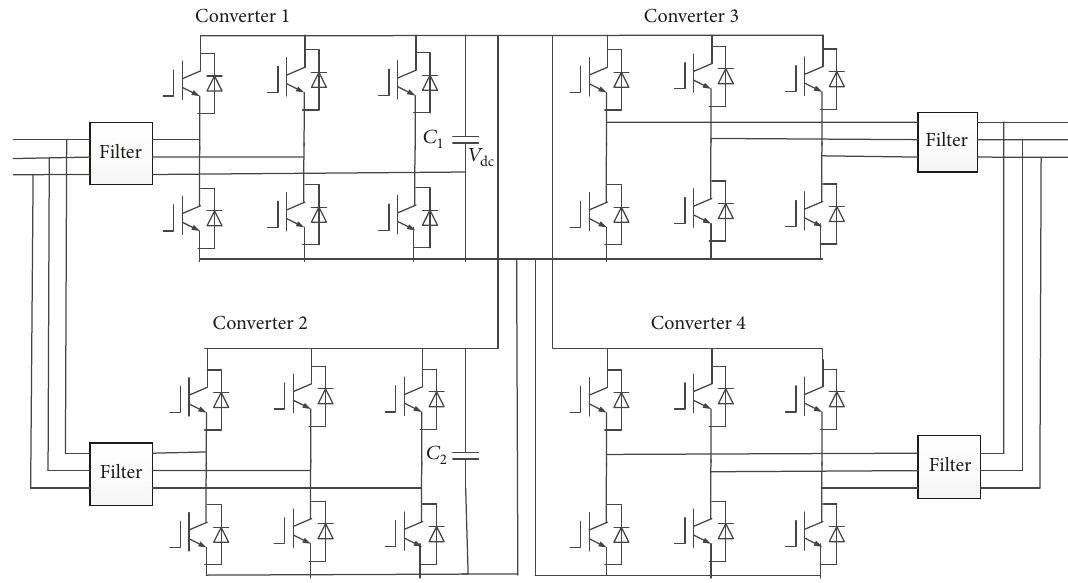
Figure 4: Two-level back-to-back VSC in parallel connection